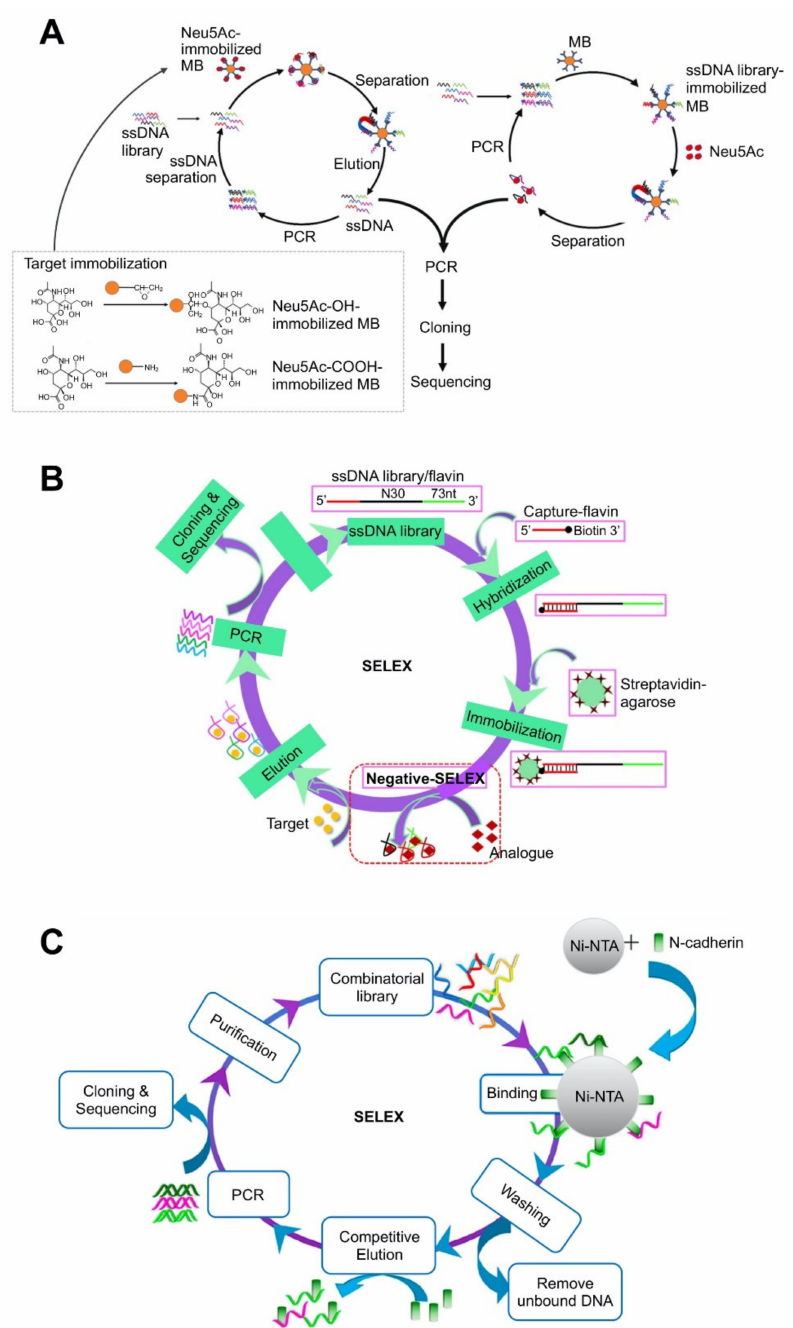
Figure 1. Aptamer discovery strategy using bead–based platforms: ( A ) N-acetylneuraminic acid (Neu5Ac)-specific aptamer selection using a magnetic bead platform. Reproduced with permission from [58]; ( B ) Riboflavin-specific aptamer selection using an agarose bead platform. Reproduced with permission from [64]; ( C ) His-tagged N-cadherin protein-specific aptamer selection using a nickel Sepharose bead platform. Reproduced with permission from